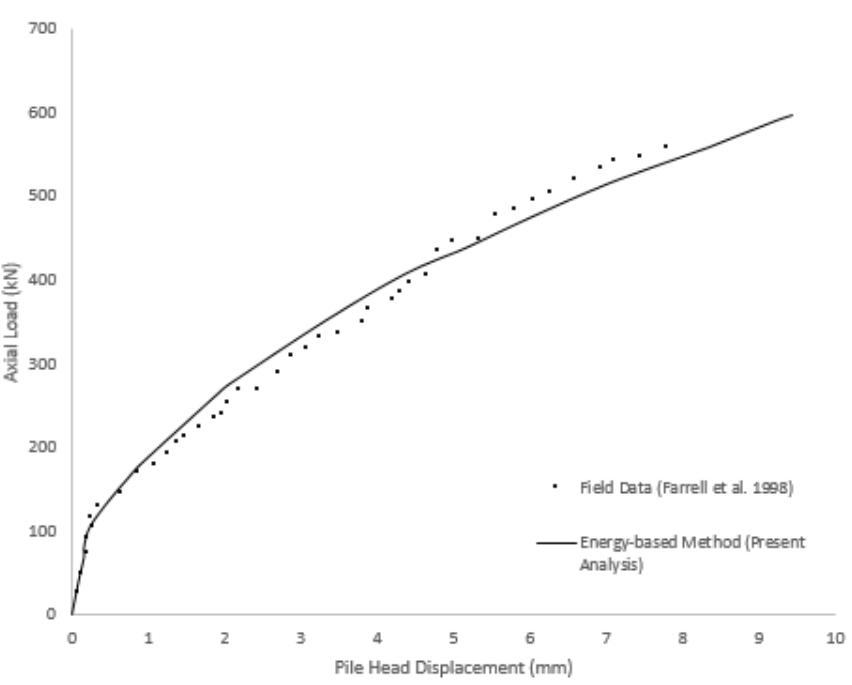
Figure 14. Response of the axially loaded pile head versus the axial load.